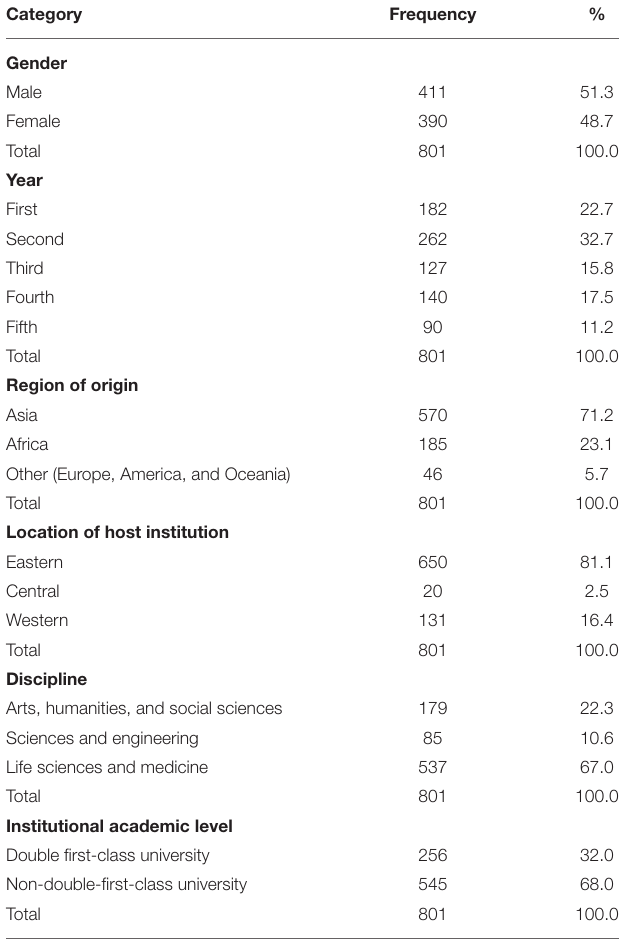
TABLE 1 | Questionnaire respondents’